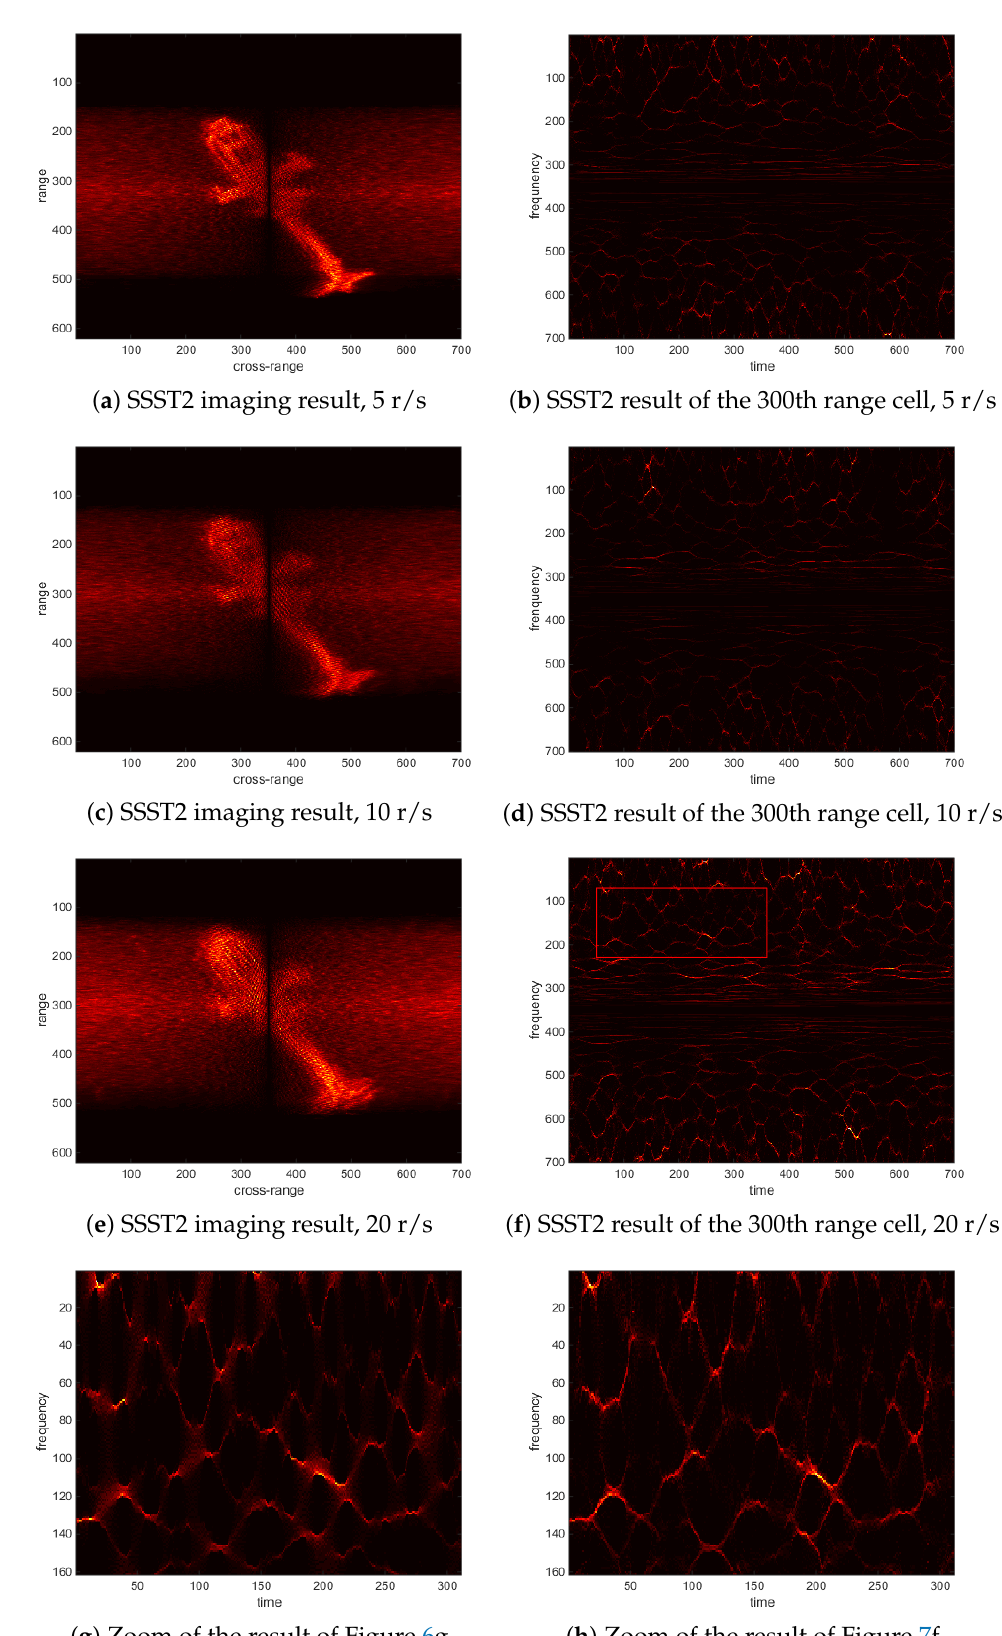
Figure 7. Second-order synchrosqueezing S-transform (SSST2) results of target with different main rotor